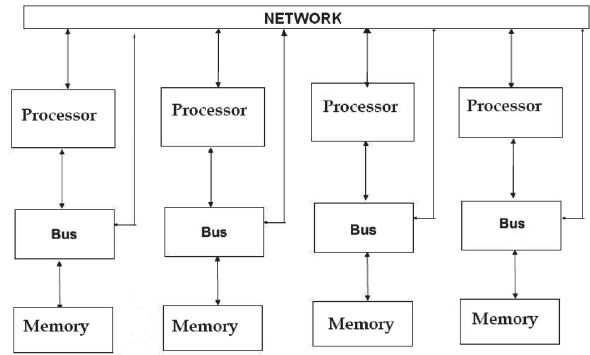
Fig. 2. Schematic representation of Distributed Memory